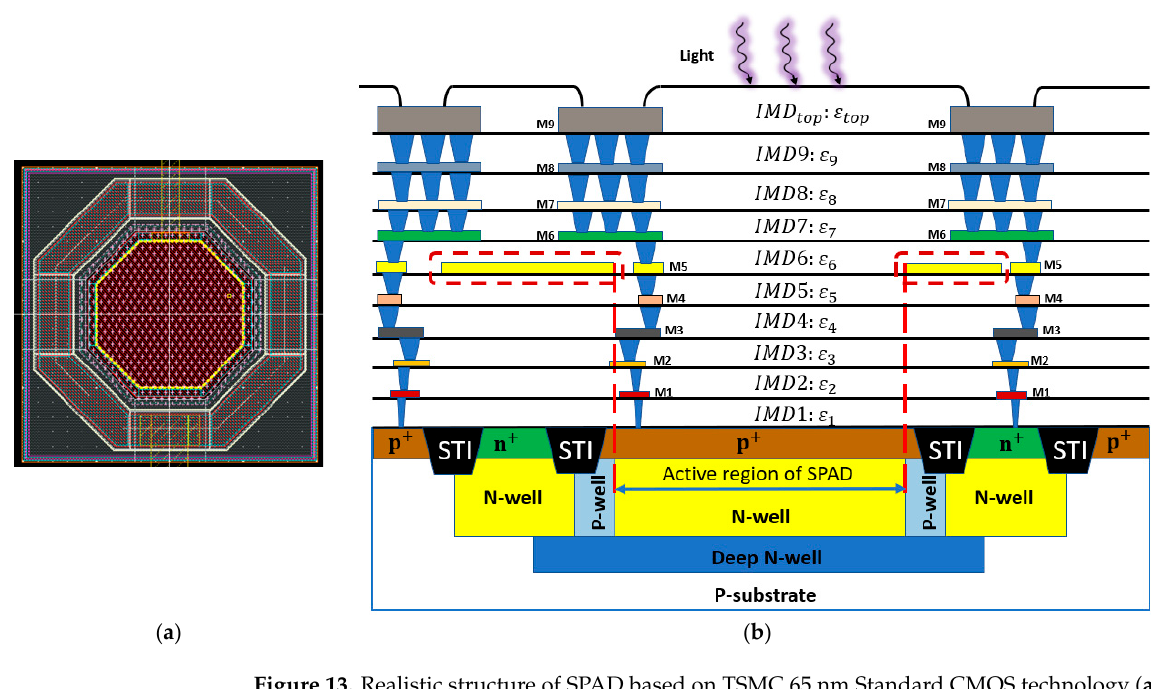
Figure 13. Realistic structure of SPAD based on TSMC 65 nm Standard CMOS technology ( a ) Layout view (top view) ( b ) Cross-sectional view of the